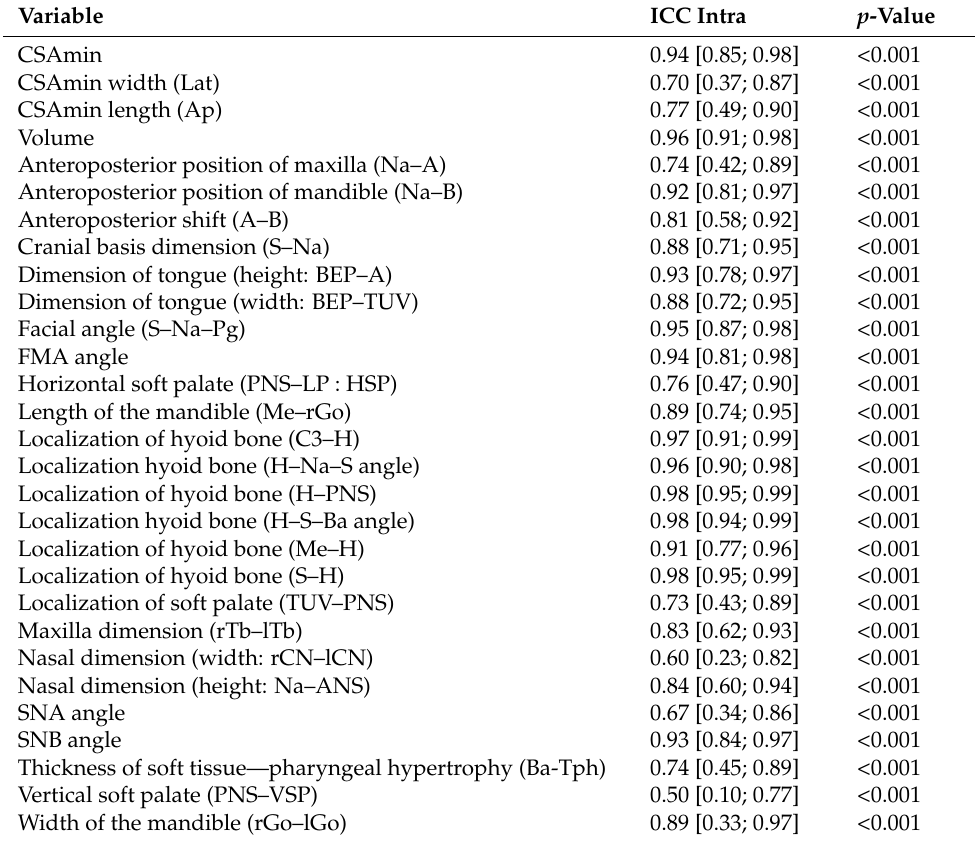
Table 4. Intraclass correlation coefficient (ICC) for the intra-observer